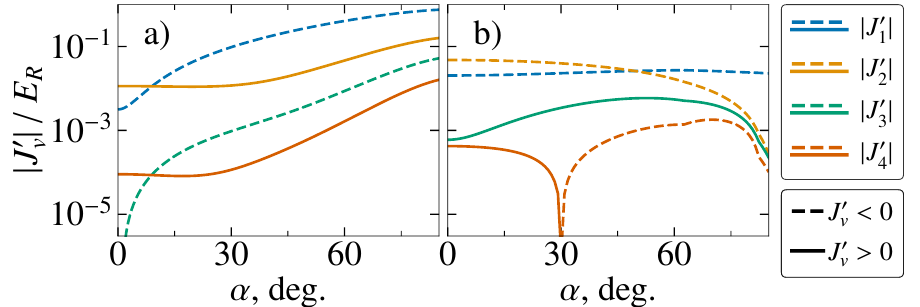
Figure 9: Absolute values of the first four tight binding tunneling parameters J (cid:48) the first and b) second energy bands as a function of the phase α for ε = Ω = 2000 E and Ω . Dashed (full) lines correspond to negative (positive) values of J (cid:48) p R